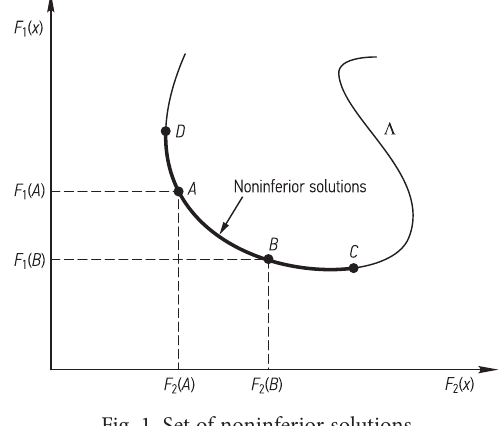
Fig. 1. Set of noninferior